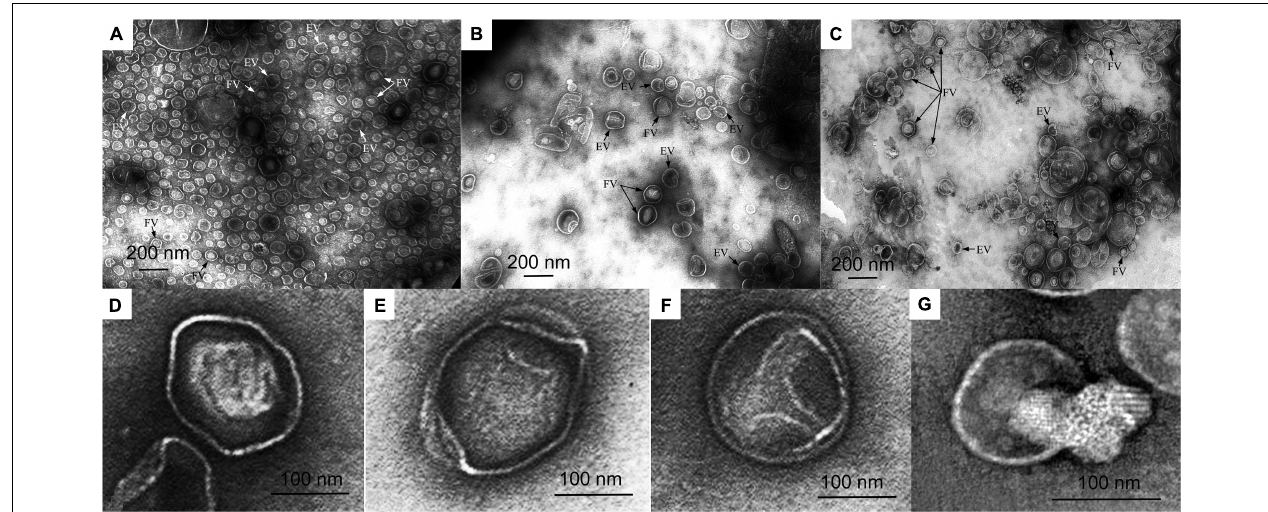
FIGURE 3 | Electron microscopy of vesicle preparations. (A) Wild-type Lysobacter sp. XL1 vesicles. (B) Lysobacter sp. XL1 (cid:49) alpB::tet mutant strain vesicles. (C) Lysobacter sp. XL1 (cid:49) alpB::alpB complemented strain vesicles. (D) Representative outer membrane vesicle (OMV) with a clear-cut dense polygonal core. (E) Representative OMV with diffusely distributed low-density contents. (F) Representative OMV with small contents in the form of a small loose granule at the periphery inside the vesicle. (G) Representative empty (or broken) vesicle that seems to have spilled its contents. Vesicles from (D–G) are from the mutant strain. EV, empty vesicle; FV, full vesicle.